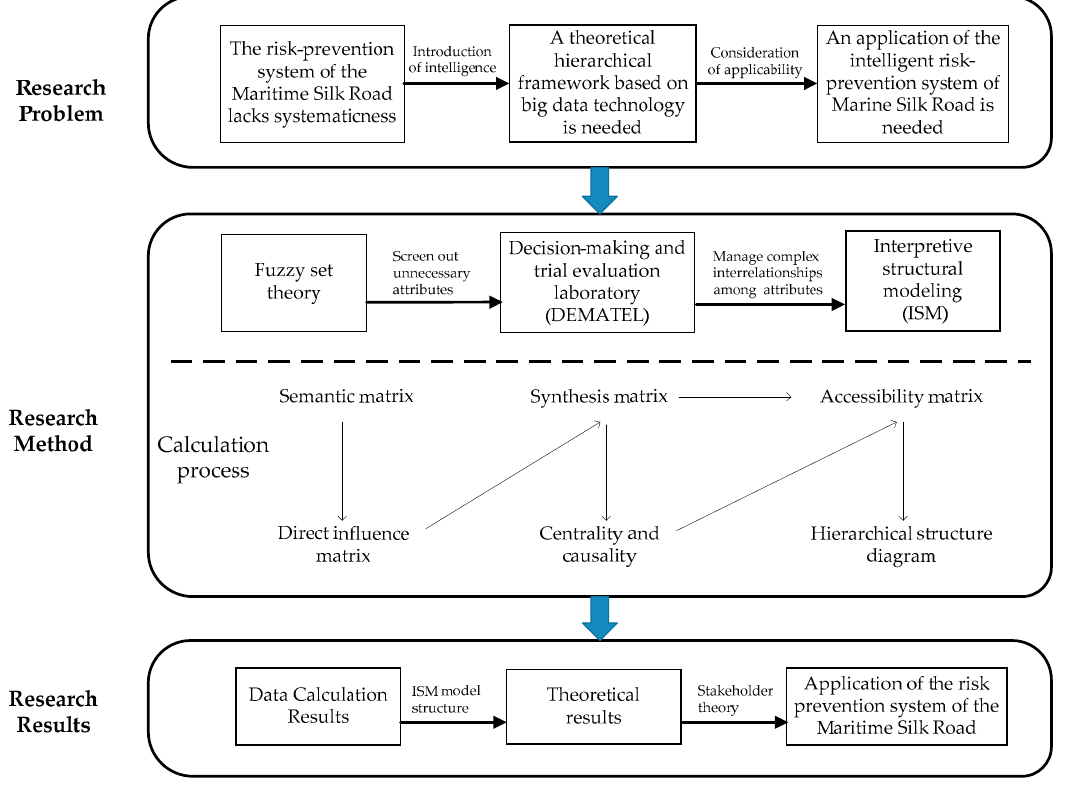
Figure 1. Research Figure 1. Research design.